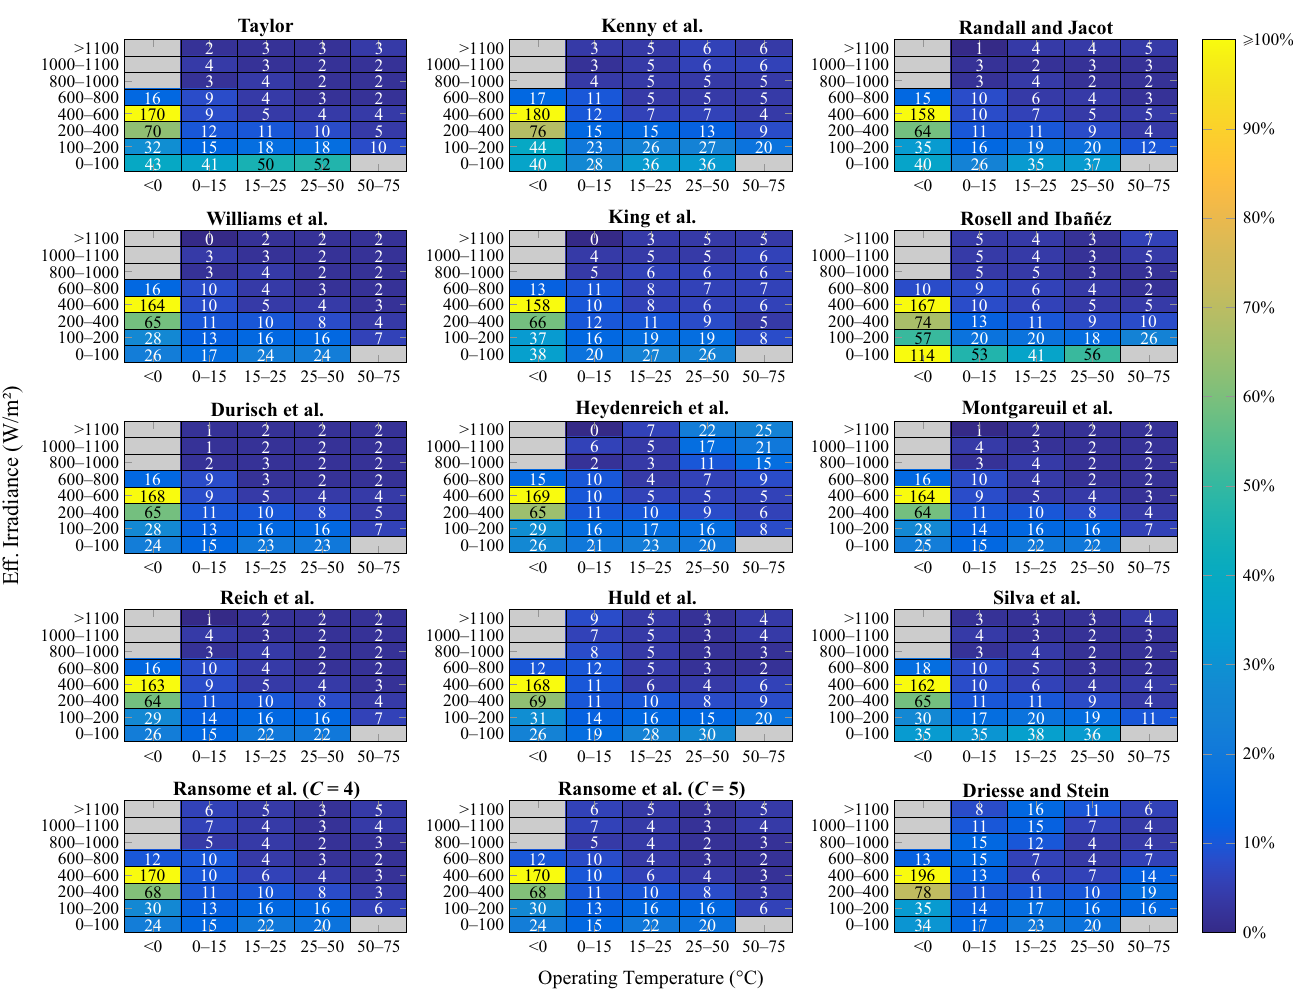
Figure 8. RMSE values (%) calculated from the results obtained by each empirical model for the different range of operating conditions verified for the PV modules under study, when they were applied considering the conventional